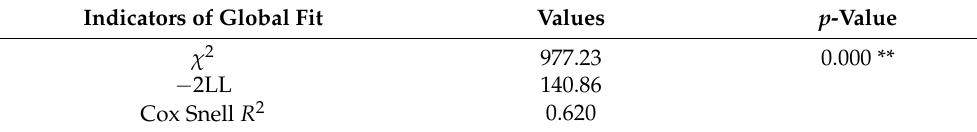
Table 6. Estimated model fit.